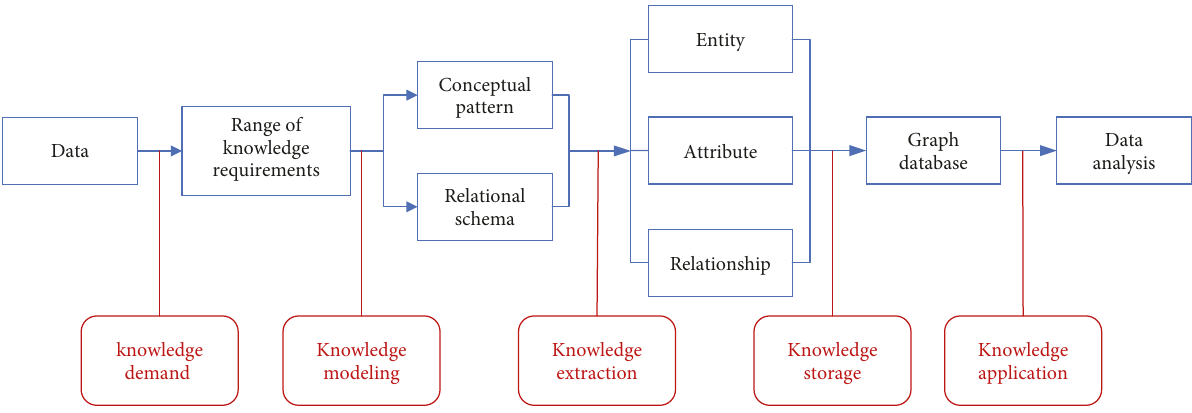
Figure 3: Life cycle diagram of traffic accident knowledge